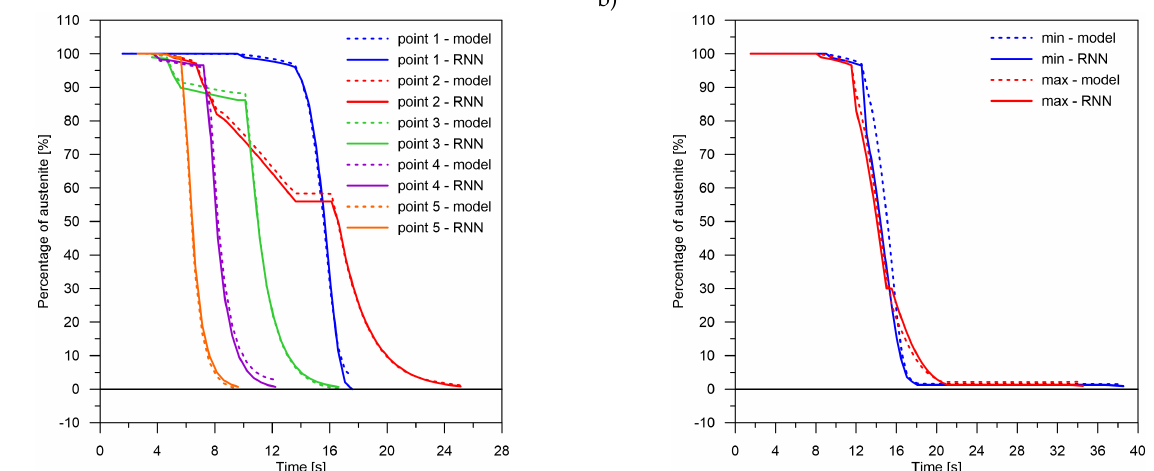
Figure 10. Kinetics of transformations: a comparison of the analytical model with the RNN model for case No. 3.